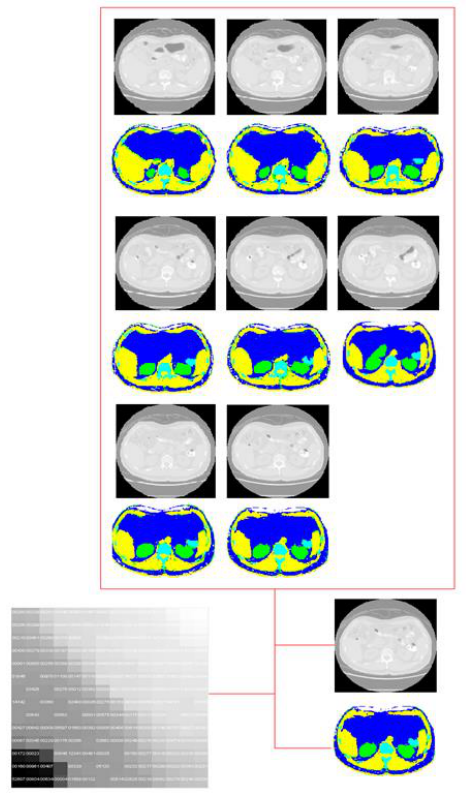
Figure 26. Kidney and liver gray level slabs and their corresponding segmentations. A representative segmentation along with its 14 × 14 neural map.